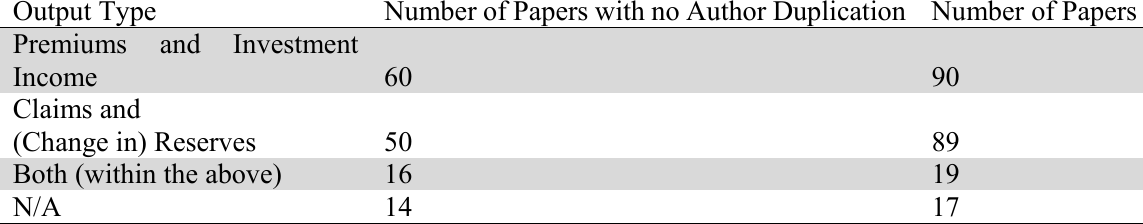
Counts of output proxy